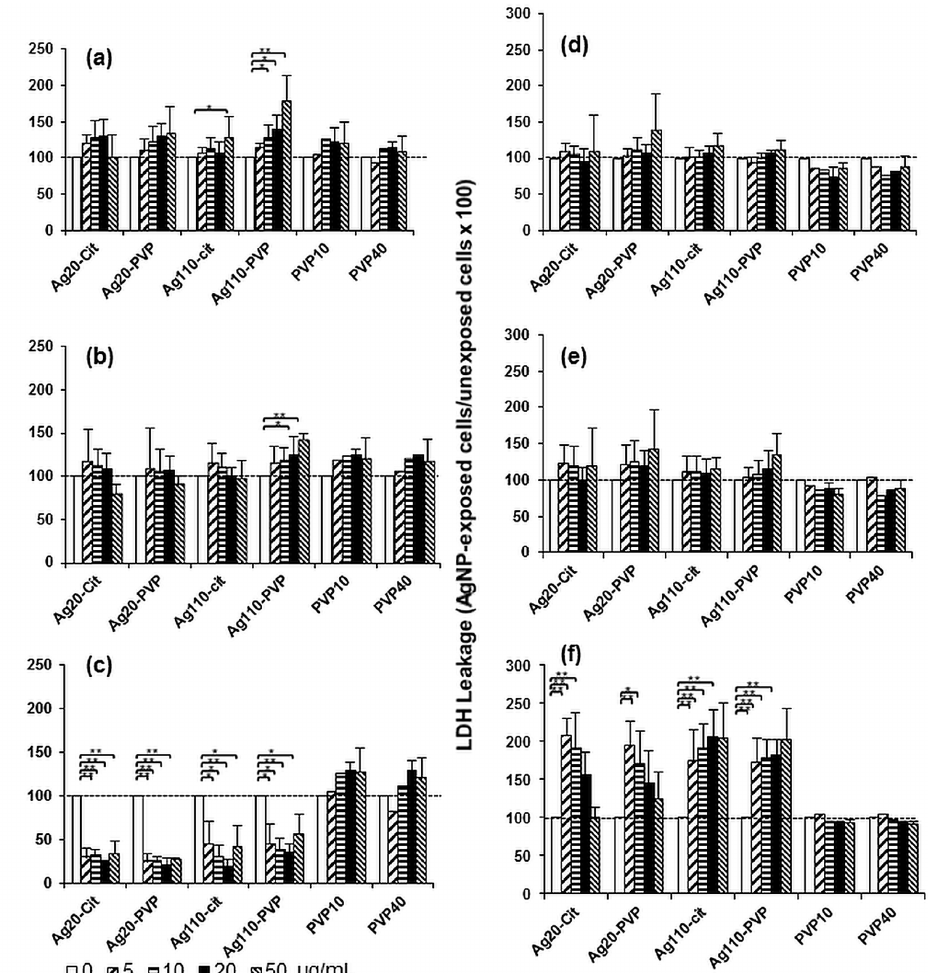
Fig 3. Cytotoxic effects of AgNP in MDM. MDM were exposed to 5, 10, 25 and 50 μ g/mL of Ag20-cit, Ag20-PVP, Ag110-citrate, Ag110-PVP and the stabilizers PVP10 (0.2, 0.3, 0.7 and 1.7 μ g/mL) and PVP40 (0.3, 0.6, 1.3 and 3.1 μ g/mL) for 3, 6 and 24 hours at 37°C in a humidified 5% CO 2 environment. MDM cultured in complete culture media without NP exposure (0) were used as unexposed controls. Cell viability (panels a , b and c ) and cytotoxicity proportional to LDH leakage (panels d , e and f ) were measured by MTS and LDH assays, respectively. Percentages of viable cells were calculated as ratios of ODs of NP-exposed MDM (after the subtraction of background) to the ODs of unexposed MDM (after background subtraction) x 100. Toxicity was defined as percent (%) LDH leakage from cells calculated from the ratios of ODs of NP-exposed MDM (after background subtraction) to the ODs of unexposed MDM (after background subtraction) x 100. Each data point represents the mean ± SD from three independent experiments. Statistical significance relative to unexposed control MDM are shown as * ( p < 0.05) or ** ( p < 0.01). Horizontal dashed lines represent the level of viable cells ( a , b , and c ) or LDH ( d , e , and f ) leakage in unexposed